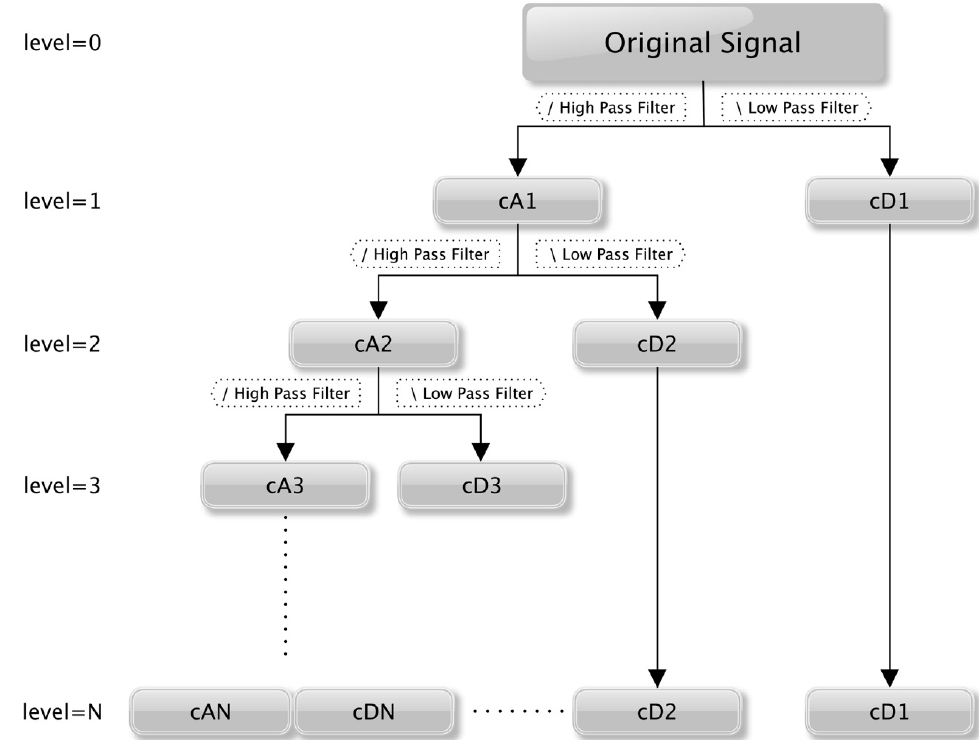
Figure 1. Wavelet multiresolution analysis of original time ‐ series.